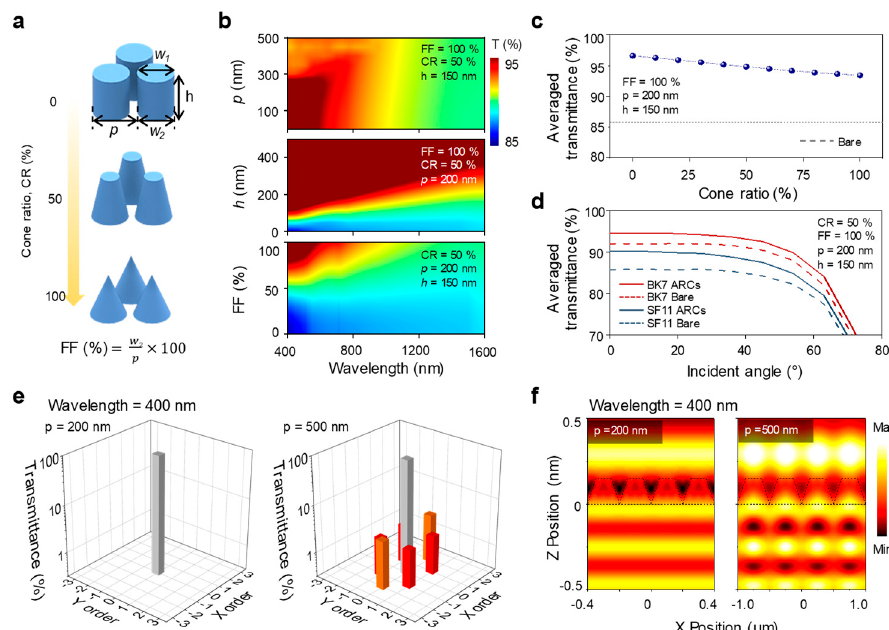
Figure 2. ( a ) Schematic illustration of rod, truncated cone, and cone-shaped nanostructures in terms of cone ratio. ( b ) Calculated transmittance profile of SF11 flat glass with SiO 2 DARCs in a wavelength range from 400 to 1600 nm as a function of the period, p (top), height, h (middle), and FF (bottom). ( c ) Calculated average transmittance spectrum of SF11 with DARCs lens as a function of the cone ratio. The dashed line represents the average transmittance of the SF11 bare lens. ( d ) Calculated average transmittance as a function of angle of incidence. ( e ) Bar profiles of the diffraction efficiency of DARCs lens with a period of 200 (left) and 500 nm (right) at a wavelength of 400 nm. ( f ) Electric field distribution of the period at 200 and 500 nm. The dashed line displays the structure outline.